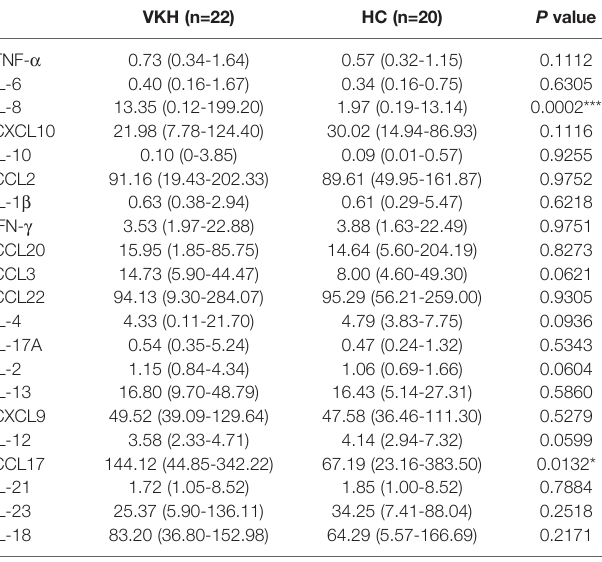
TABLE 3 | Comparison of plasma cytokines between VKH patients and healthy controls.